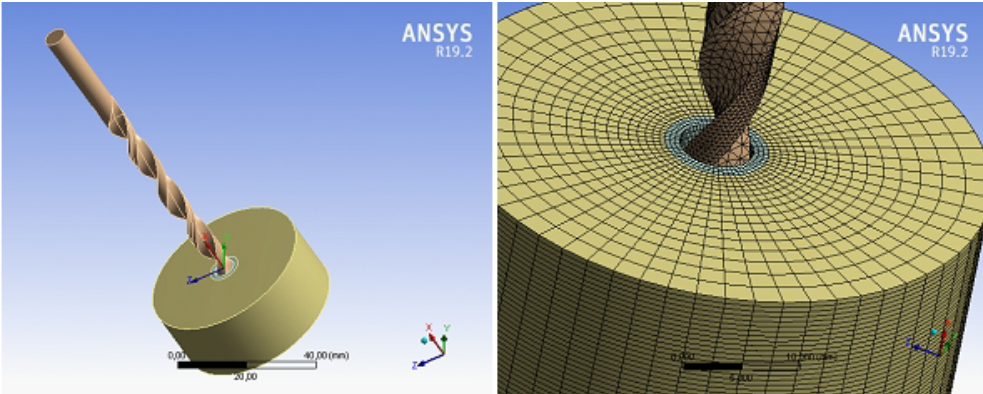
Figure 30. Ansys imported assembly of the drill bit and mesh of the assembly.